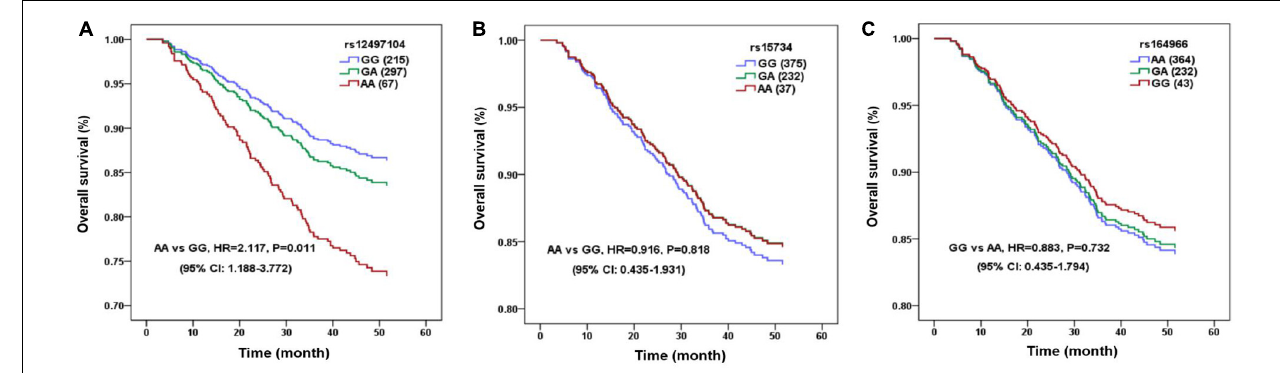
FIGURE 1 | Linc00312 single nucleotide polymorphisms (SNPs) are associated with OS of nasopharyngeal carcinoma (NPC) patients. The survival curve of NPC patients with different genotypes of rs12497104 (A) , rs13734 (B) , and rs164966 (C) .